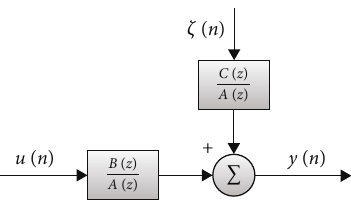
Figure 2: Block diagram of secondary path modeling based on